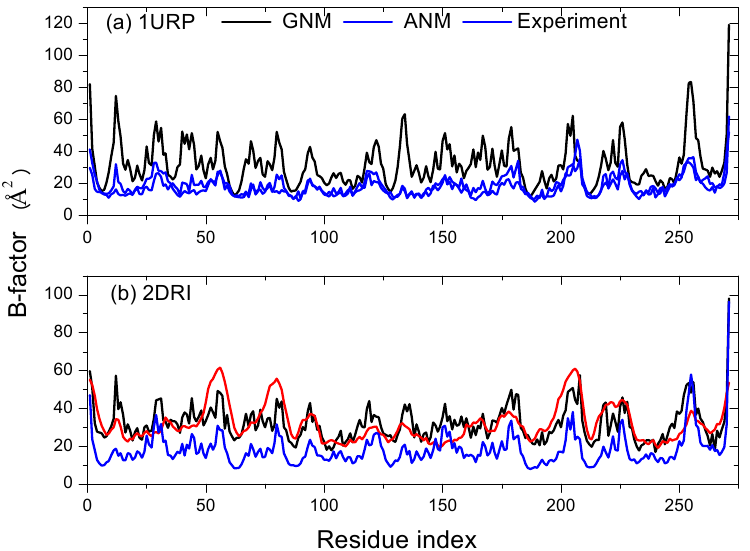
Figure 2. Comparison of theoretical and experimental B-factors for ( a ) 1URP and ( b )